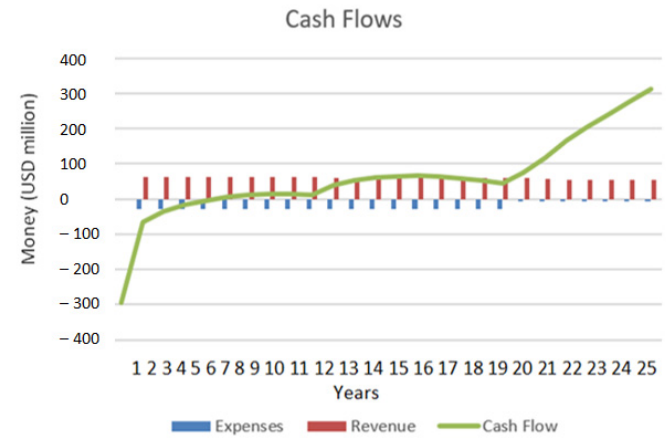
Figure 16. Cumulative cash flow chart for Hickman solar farm [30].